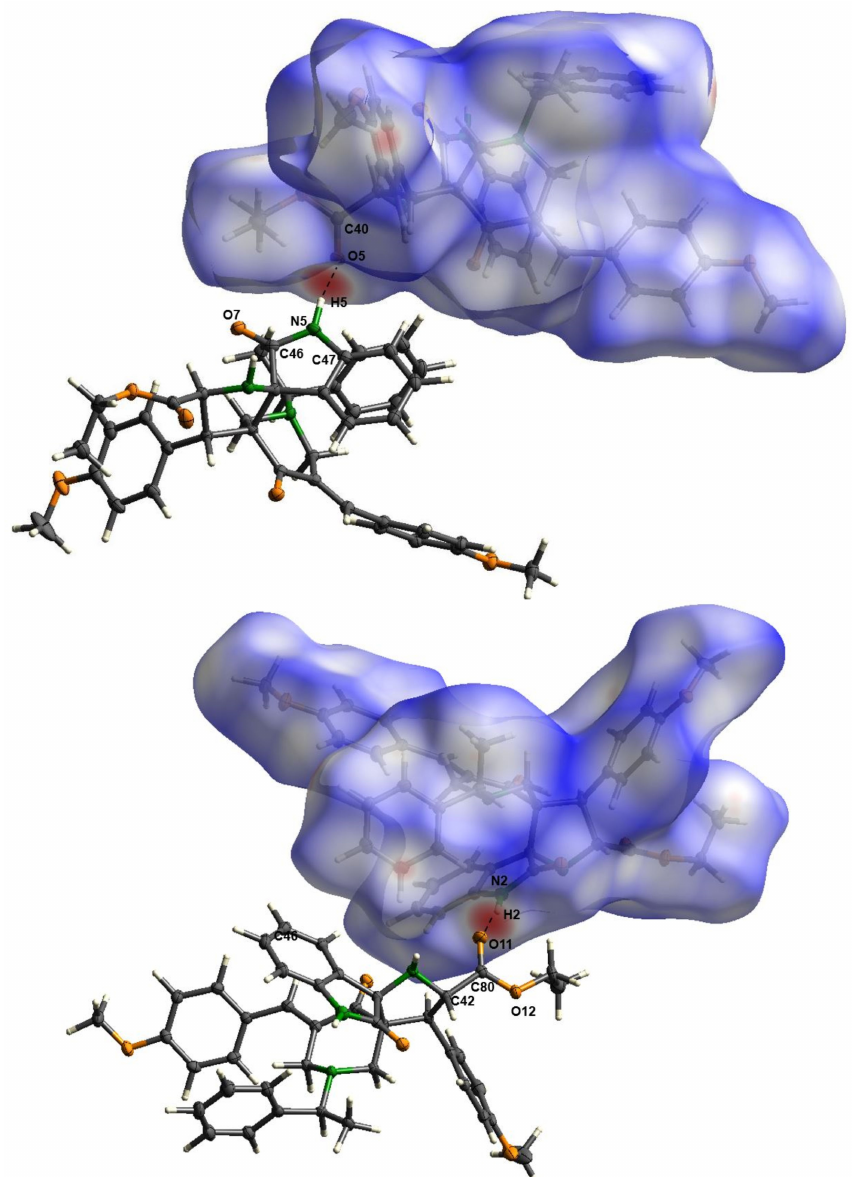
Figure 5. Hirshfeld surface analysis of molecule 4c highlighting close contacts in the crystal structure between the two independent compounds. Selected close contacts [Å] and angles [ ◦ ]: N1–H1